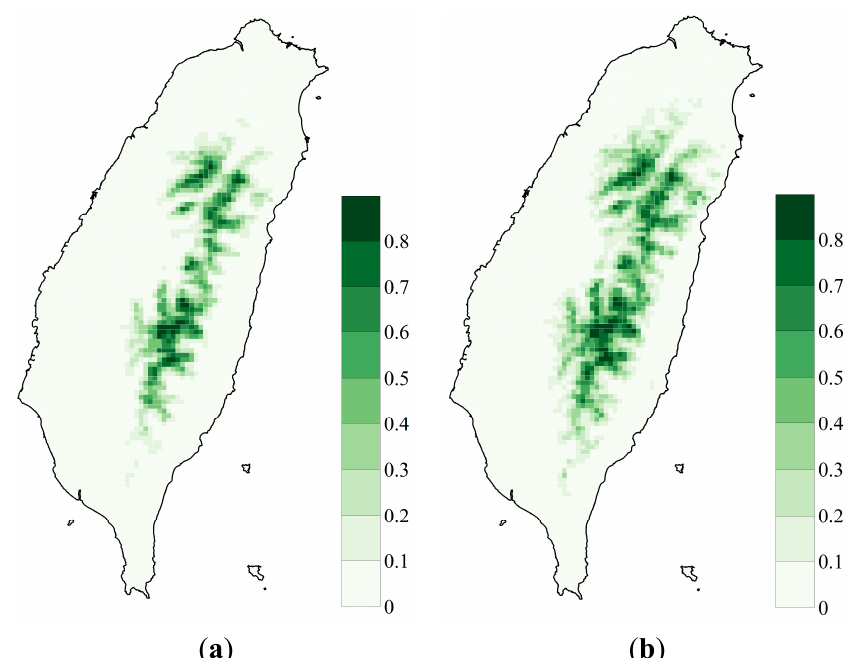
Figure 2. The predicted baseline habitat suitability for: ( a ) Abies ; ( b ) Tsuga .